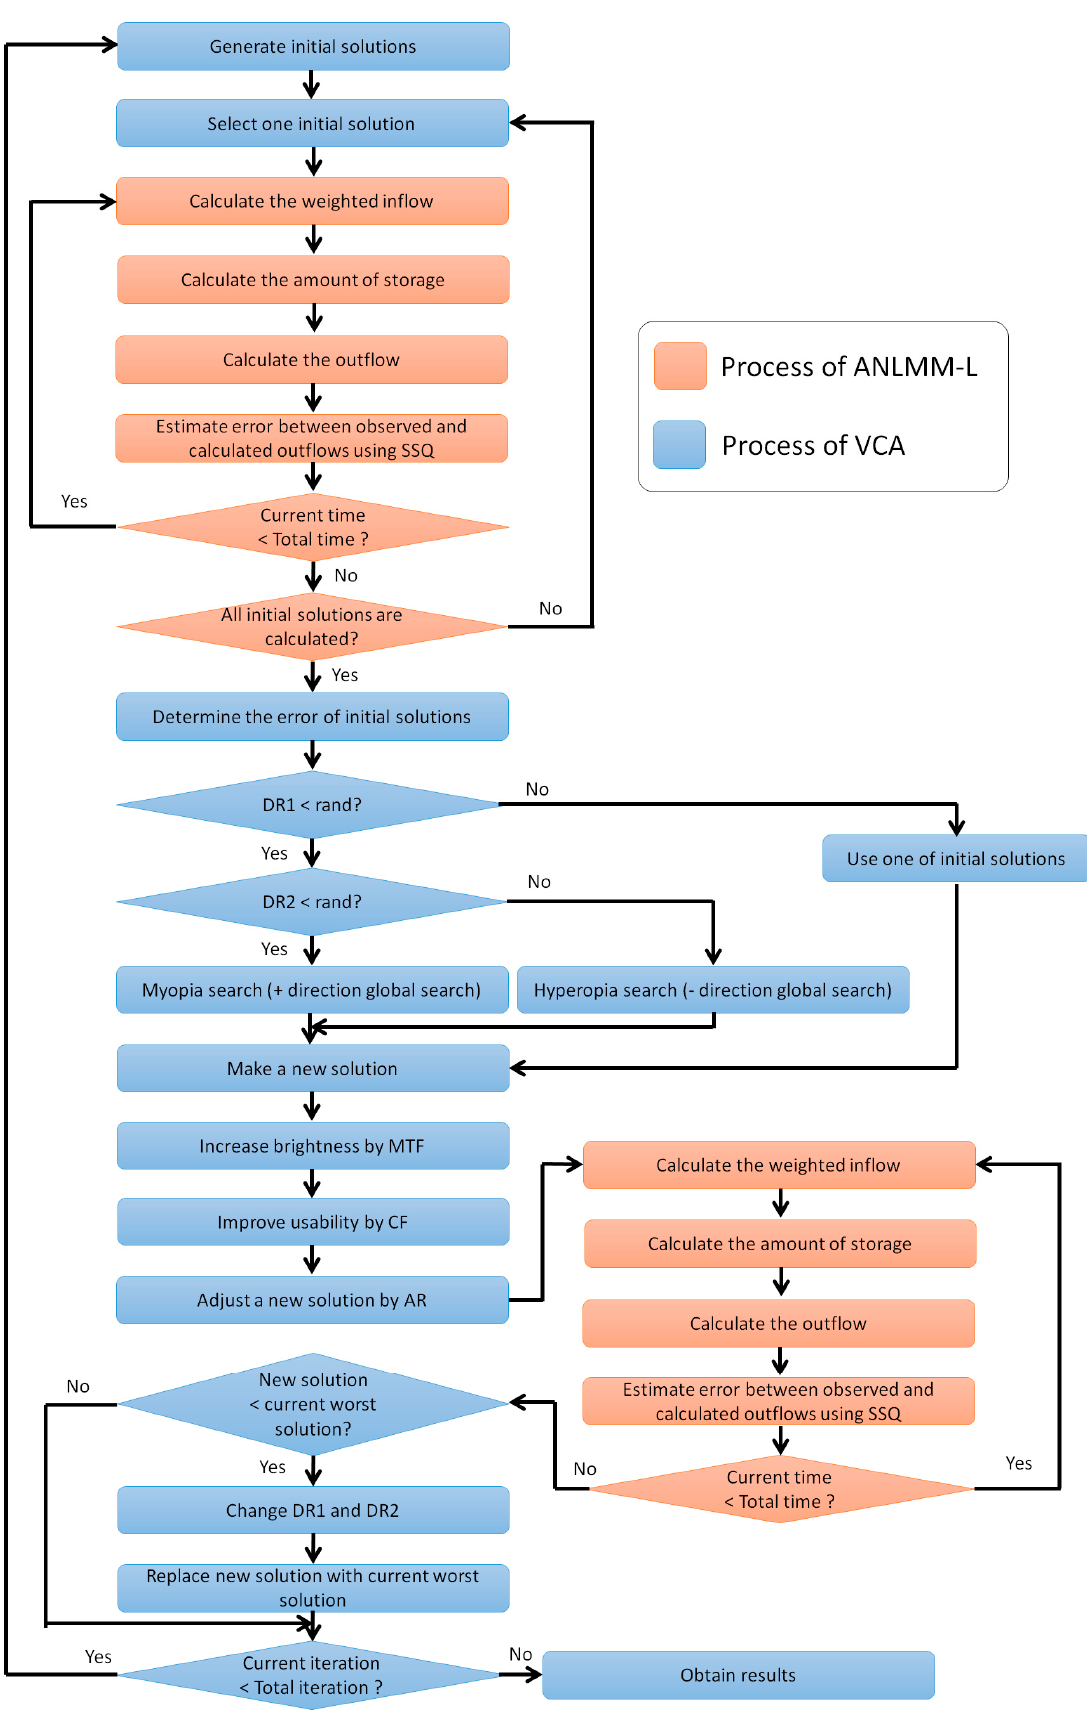
Figure 1. Flowchart for the calculation of ANLMM-L and VCA.